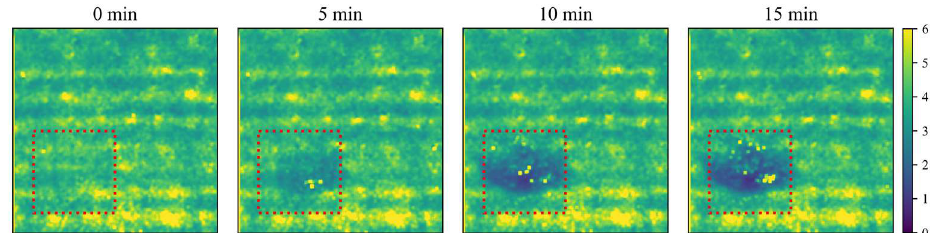
Figure 7. Changes in the absorption coefficient of bruised tissue of ‘crown’ pears.